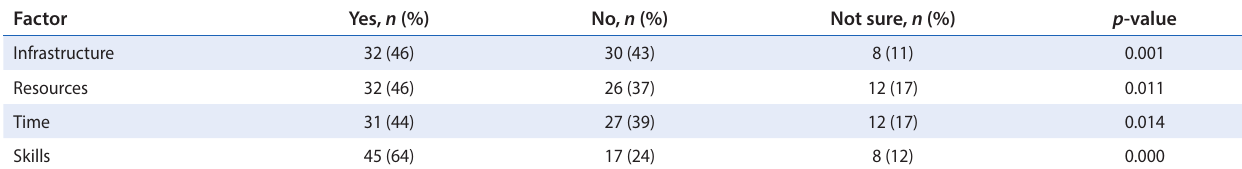
Table 6: Readiness of private sector doctors for the implementation of NHI with regard to infrastructure, resources, time and skills ( n = 70)